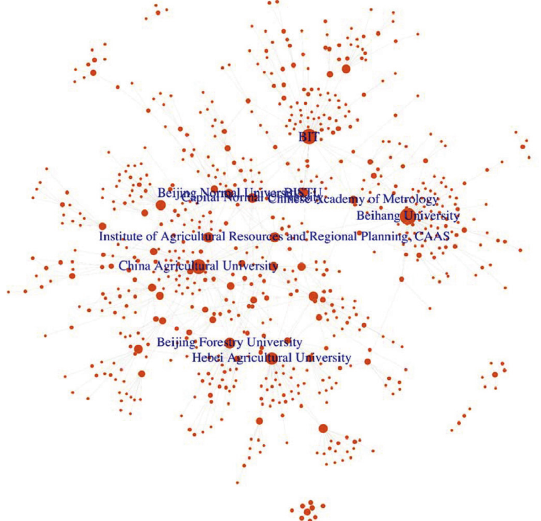
Figure 7: Community of innovation with multiple centers of Beihang University, Beijing Institute of Technology, and China Agricultural